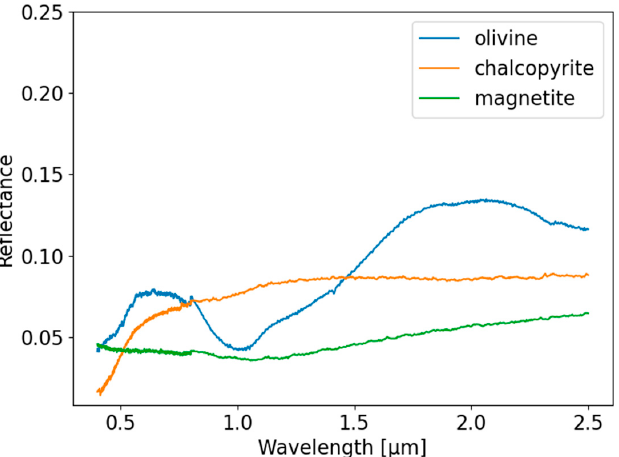
Figure 4. Comparison of chalcopyrite, magnetite, and olivine spectra extracted from the splib07 USGS spectral library